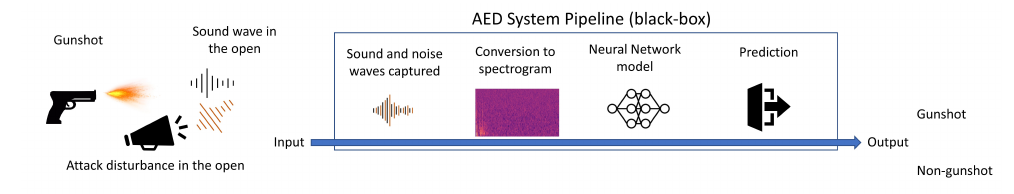
Figure 1. A hypothetical scenario where an attacker tries to evade detection by injecting noise sounds, in the open, to the audio input captured by AED